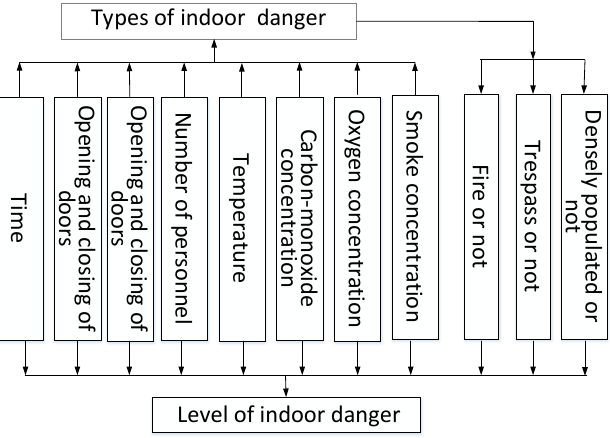
ff ecting the indoor danger types and danger coe ffi Figure 14. Factors affecting the indoor danger types and danger coefficient. Figure 14. Factors a